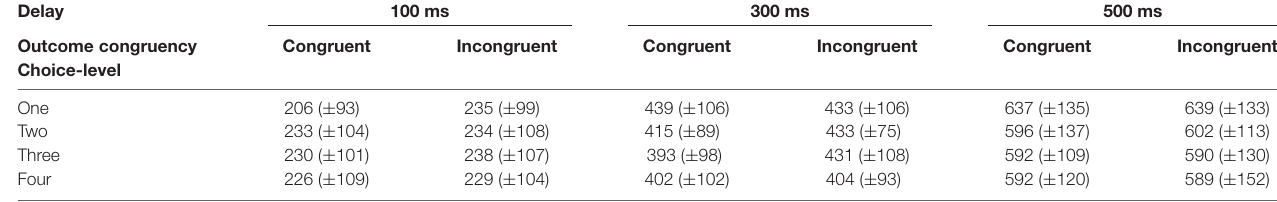
TABLE 1 | Means and standard deviations of interval estimations (ms) in each choice-level, outcome-congruency and actual delay condition.